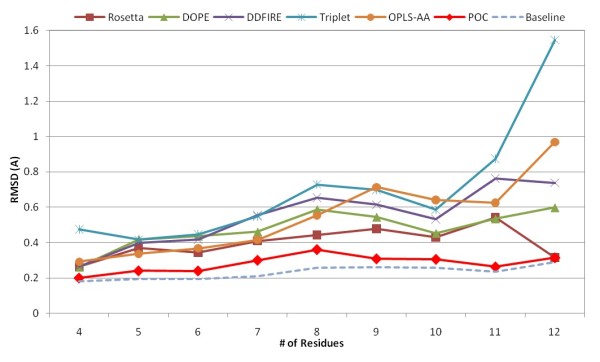
Average RMSD of the best models selected from 5-top-ranked decoys in Jacobson's loop sets ranging from 4 to 12 residues.